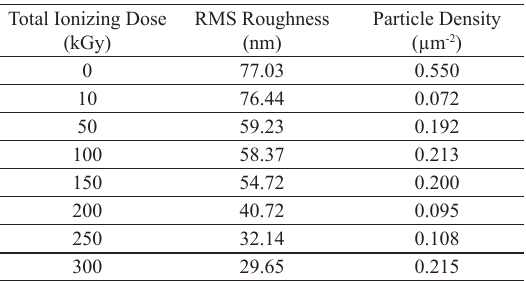
Table 1. Summary of structural parameters of TIPS Pentacene thin films before and after irradiation with different total ionizing doses. Total Ionizing Dose (kGy)